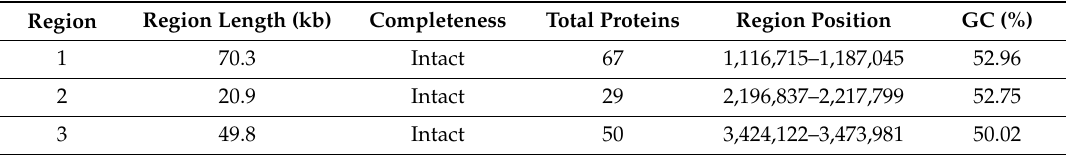
Table 3. Intact prophage regions identified in genome of Enterobacter sp.